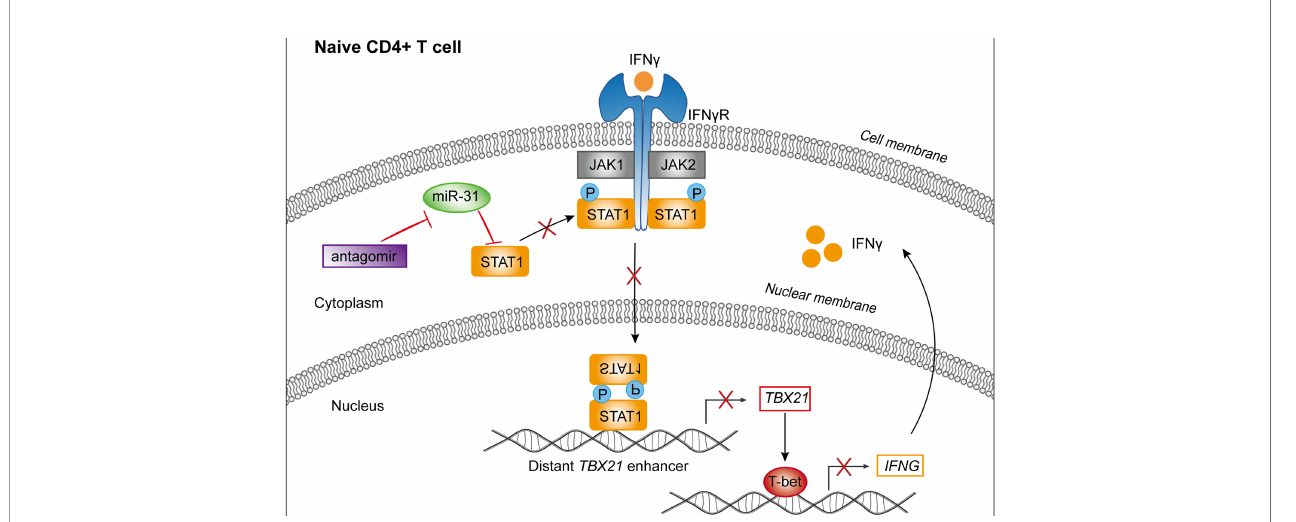
FIGURE 5 | Schematic representation of the mechanism by which miR-31 regulates the homeostasis of CD4+ T cells. miR-31 downregulates the STAT1-T-bet-IFN- g feedback loop via directly targeting STAT1, thus serving as a gatekeeper of CD4+ T cell